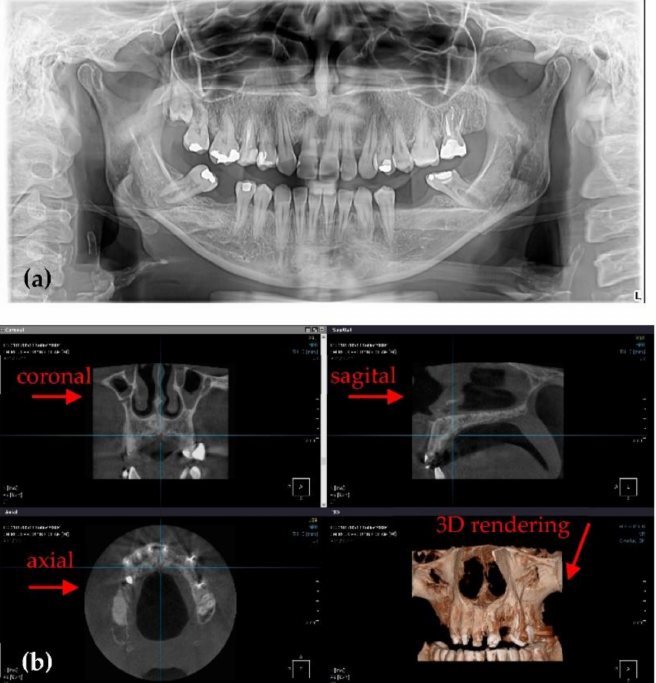
Figure 2. Examples of images obtained with Soredex setups (for a healthy member of the clinic’s staff): ( a ) panoramic and ( b ) 3D CBCT, the latter showing coronal, sagittal, axial views, as well as a 3D volumetric